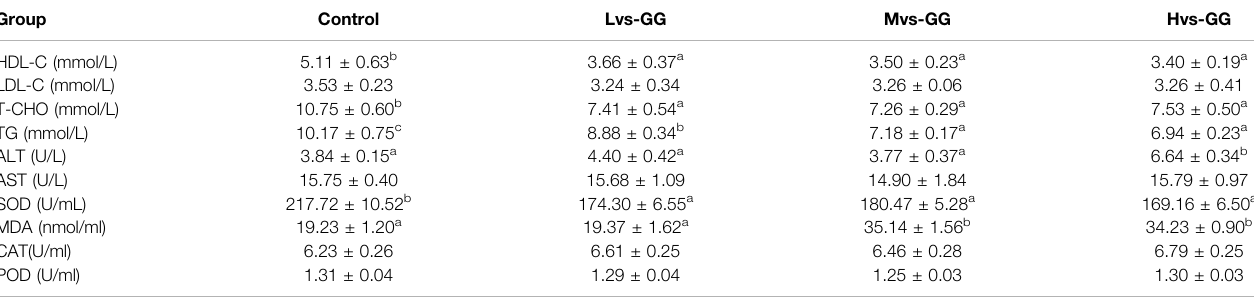
TABLE 7 | Effects of different viscous guar gum on serum biochemical parameters of juvenile largemouth bass.